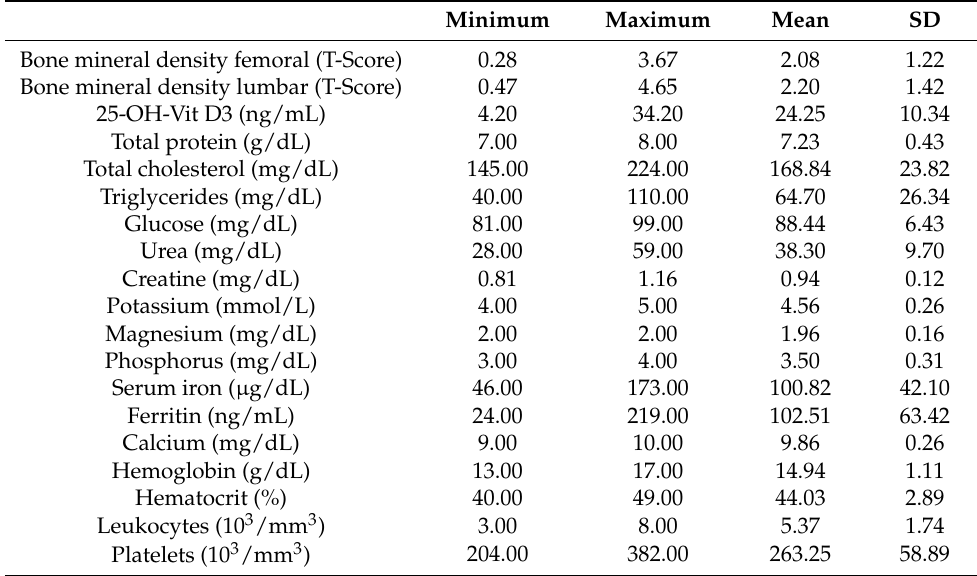
Table 2. Bone densitometry values (T-score), vitamin D3, analytical values (biochemical and hemogram) analysed in Breaking